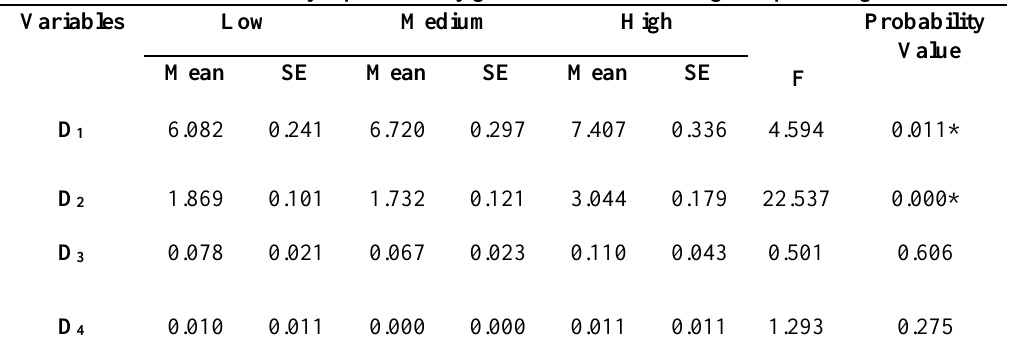
Table 3: Caries severity represented by grades of lesion according to depression grade Variables Low Medium High